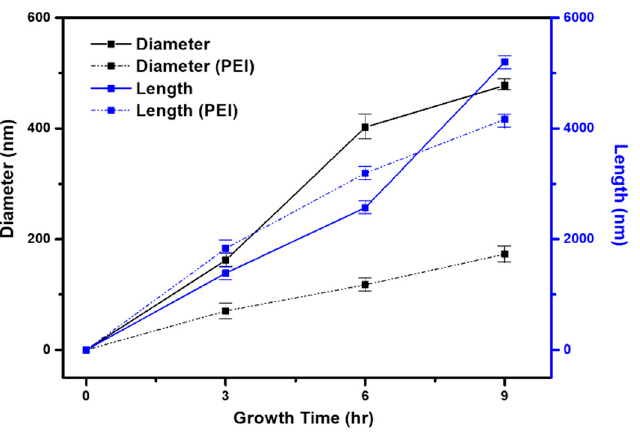
Figure 5. Diameter and length results of ZNRs prepared with various growth times at 90 °C for two cases: no PEI and PEI added to precursor solutions.